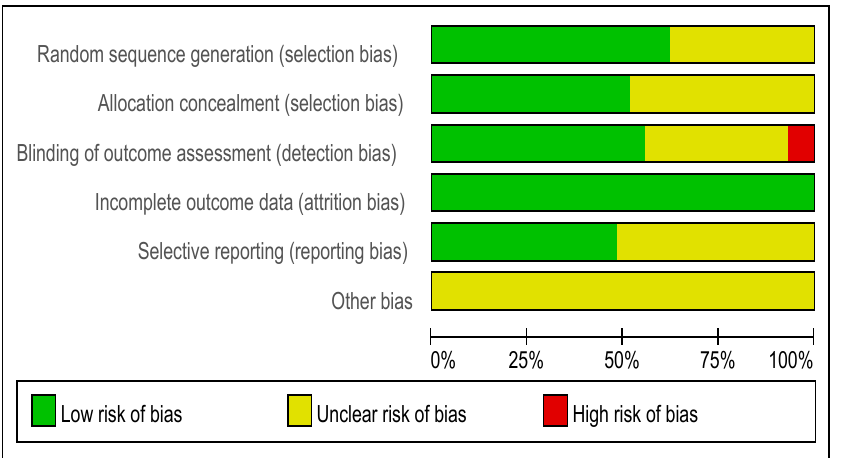
Figure 2. Risk of bias graph.